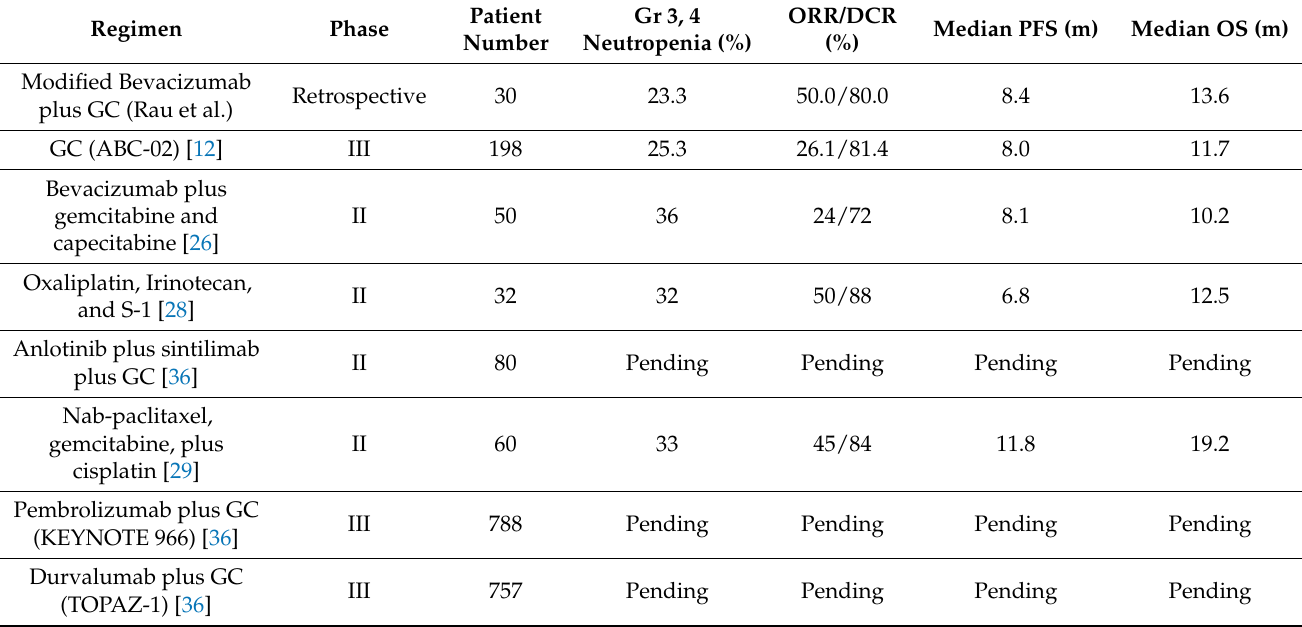
Table 7. Results of published/ongoing first line treatments for advanced biliary tract